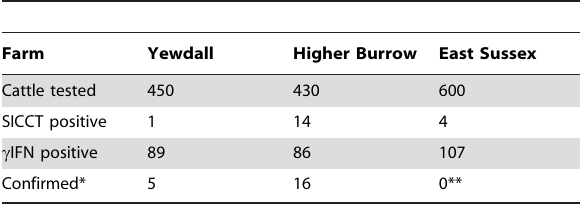
Table 1. Test results of three herds where SICCT and c IFN test were carried out in parallel [16,51,52].